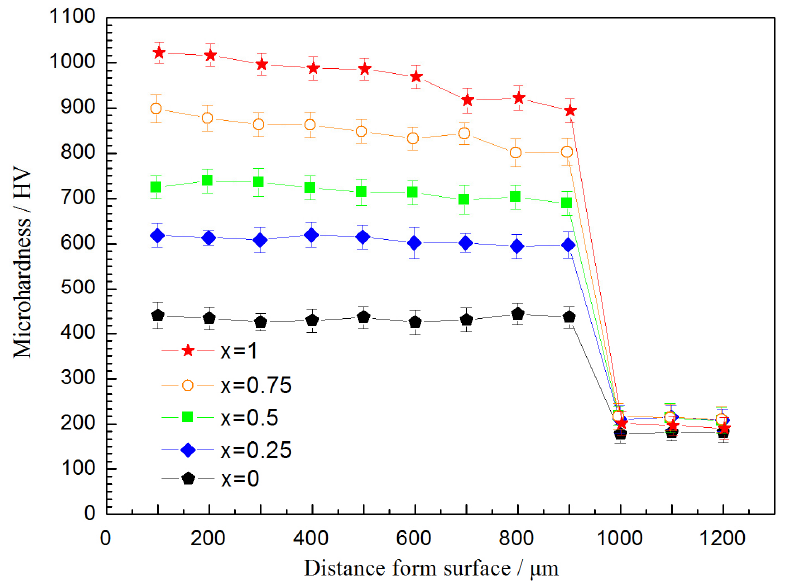
Figure 3. Results of the microhardness test along the cross section of the FeCoCrNiAlTi x HEA coatings.